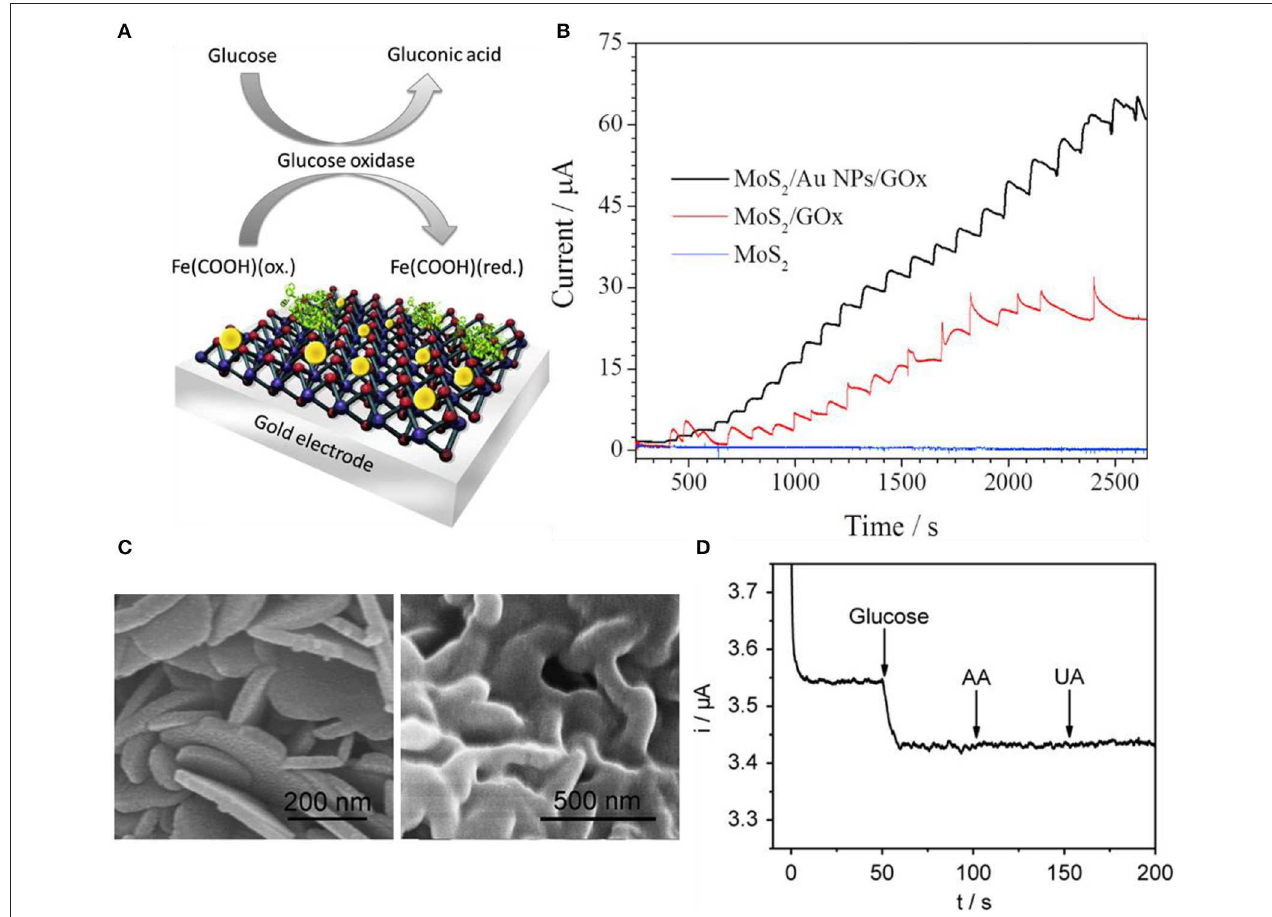
FIGURE 6 | Glucose sensors using transition metal dichalcogenides. (A) Illustration for basic glucose sensor using Au nanoparticle decorated MoS 2 . (B) Response comparison between pristine MoS 2 , MoS 2 /GOx, and MoS 2 /Au NP/GOx electrodes. Figures (A,B) were reproduced from Parlak et al. (2017) with permission from Elsevier. (C) Scanning electron microscope images of pristine SnS 2 (left) and GOx/MWCNTs–SnS 2 (right). (D) Response curves of glucose having selectivity at GOx/MWCNTs–SnS 2 . Figures (C,D) were reproduced from Li et al. (2013) with permission from